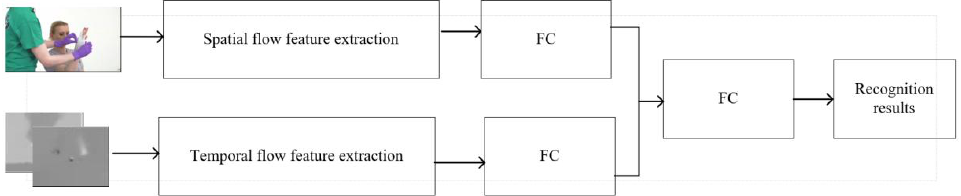
Figure 7. Mid-term fusion process.